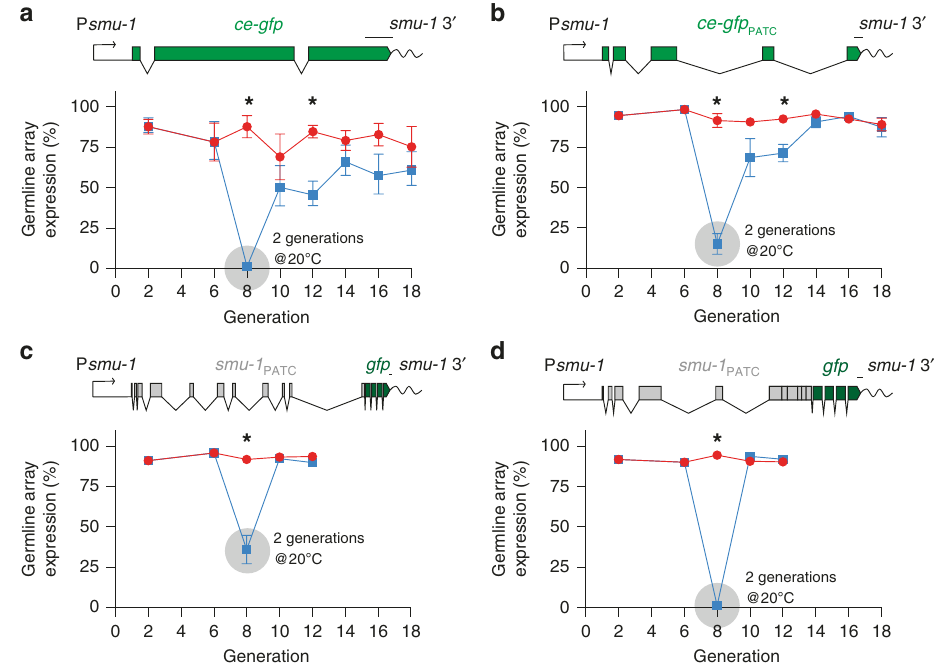
Fig. 5 Reversible, temperature-dependent silencing of PATC-rich transgenes. Quanti fi cation of GFP fl uorescence from extrachromosomal arrays in the germline over several generations. Animals were grown for two generations at a lower temperature (20 °C) (blue line) compared with controls (red line) propagated continuously at 25 °C. a Germline expression of ce-GFP containing no PATCs under the PATC-rich smu-1 promoter and 3 ′ -UTR. n = 8 biologically independent transgenic lines. b Germline expression of ce-GFP PATC under the PATC-rich smu-1 promoter and 3 ′ UTR. n = 11 biologically independent transgenic lines. c Germline expression of a gfp -tagged “ full ” length P smu-1 :: smu-1 transgene. n = 11 biologically independent transgenic lines. d Germline expression of a gfp -tagged chimeric P smu-1 :: smu-1 transgene with the last fi ve introns removed. n = 11 biologically independent transgenic lines. Transgene scale bars = 100 nucleotides. All germline fl uorescence was quanti fi ed from transgenic animals carrying simple extrachromosomal arrays imaged with a ×40 or ×63 oil objective at the indicated temperatures. Each datapoint indicates one independent measurement of germline fl uorescence scored from 11 animals from an independent transgenic line. Bars indicate the mean, and error bars indicate the SEM. Statistics: Two-way ANOVA and repeated t test corrected for multiple comparisons with the Holm – Sidak method. * p < 0.05. Source data are available in the Source Data fi